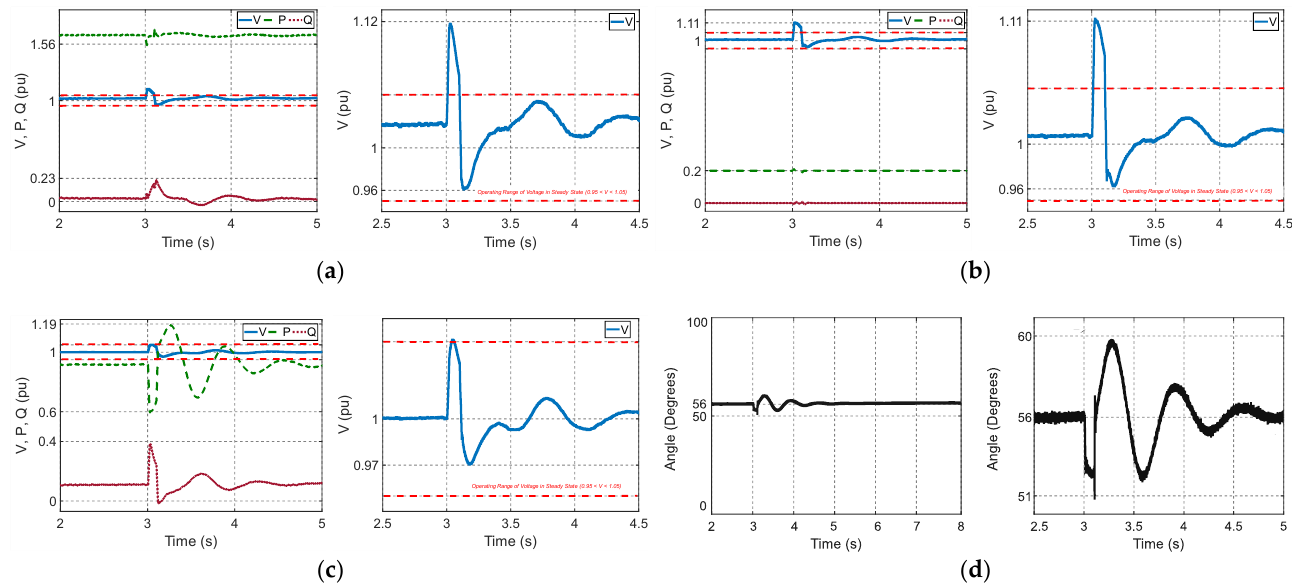
Figure 13. Scenario 2 results for the system generators: voltage (V), active power (P), reactive power (Q), and voltage zoom. ( a ) Wind power plant; ( b ) solar power plant; ( c ) hydroelectric power plant; ( d ) hydroelectric power plant: loading angle and zoom.